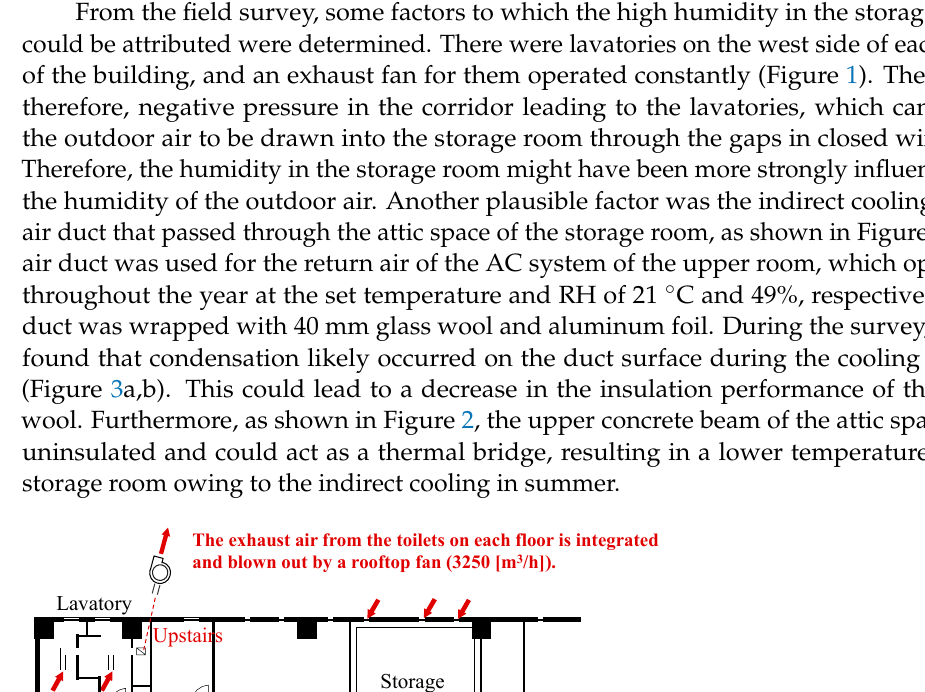
Figure 2. The duct passing through the attic space. ( a ) ( b ) Figure 3. Traces of condensation on the duct surface: ( a ) gaps in the aluminum foil wrapped around the duct, through which water vapor may enter; ( b ) water stains on the ceiling caused by condensed water falling from the duct. Table 1. Specification of the Onset UX100-011. Temperature